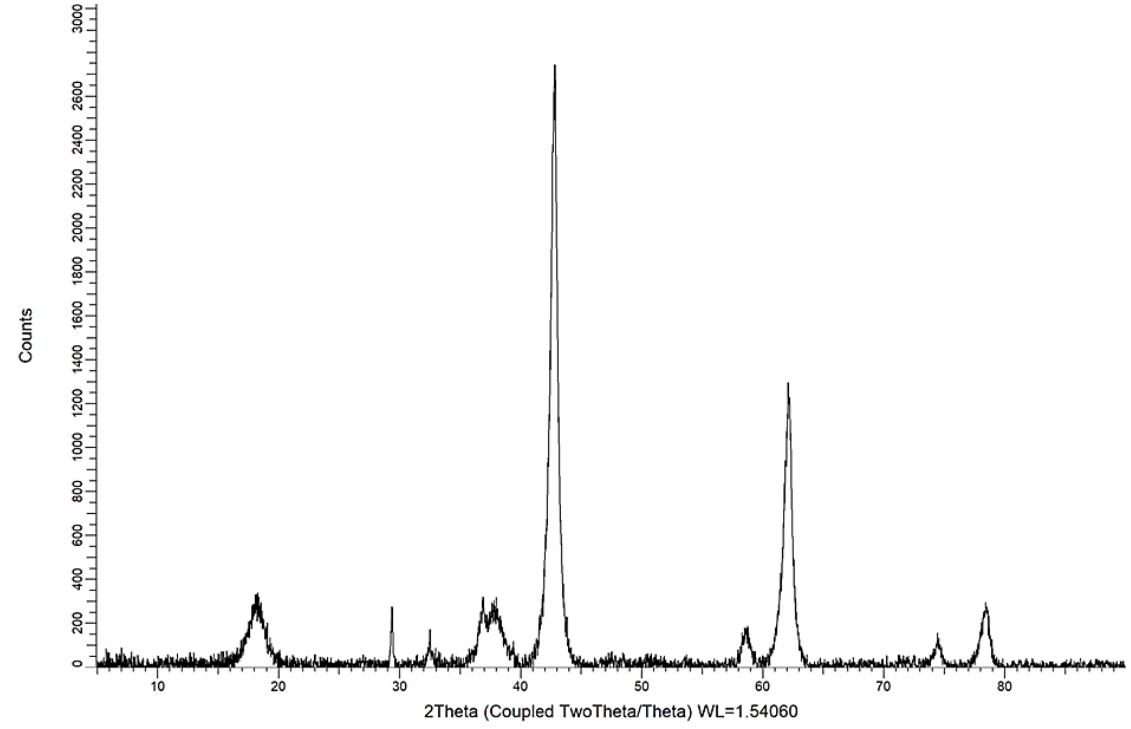
Figure 13. The XRD pattern of MgO powder.